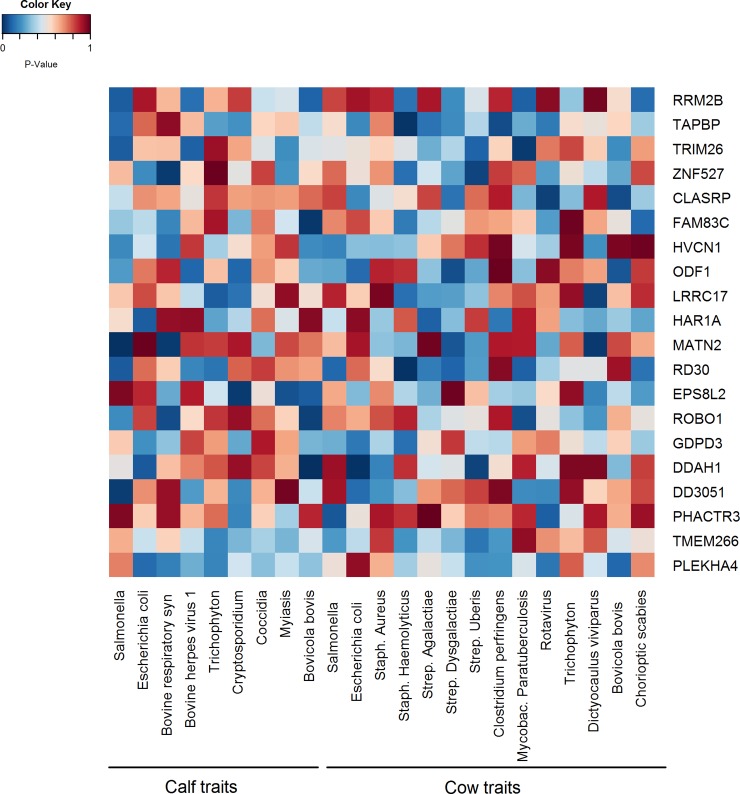
P-values for the selected annotated candidate genes in all resistance traits in calves and cows.Dark red color means very high p-value, dark blue color means very low (i.e. more significant) p-value.